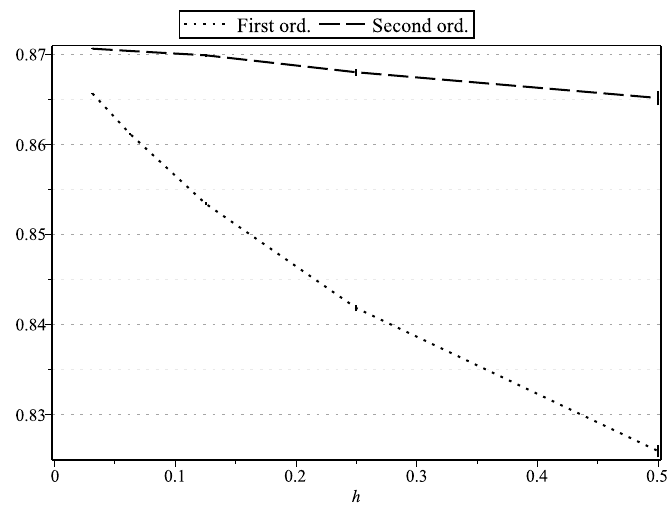
Figure 18. E e − ( 5/6 ˆ X x 1 ) as functions of h : σ = 2.0, θ = 0.04, β = 0.1, x 0 =